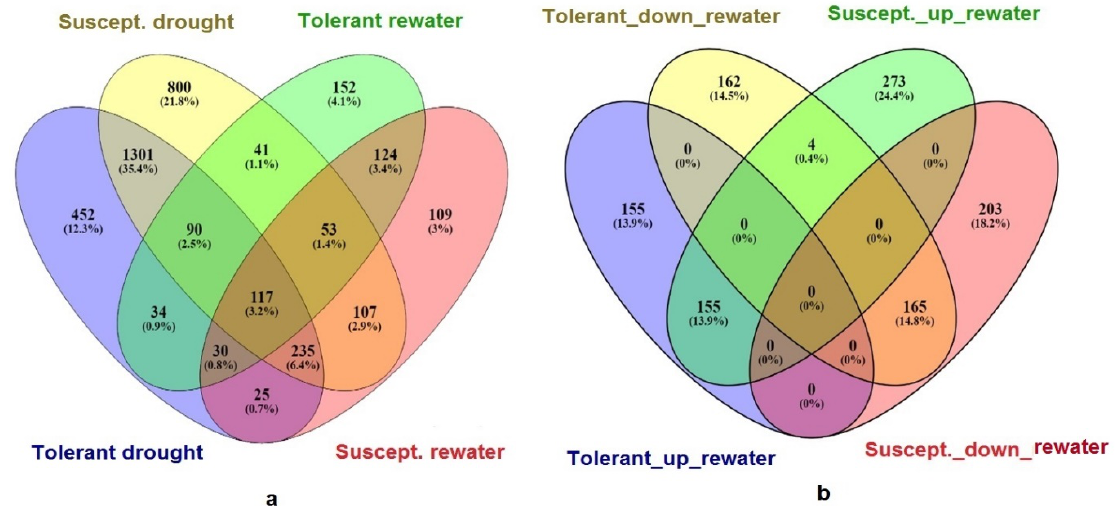
Figure 8. Differential expression of transcripts in drought tolerant (tol) and susceptible (sus) maize genotypes, under drought stress and drought recovery (rewater). ( a ) Distribution of total number of transcripts in the two genotypes under different conditions. ( b ) Number of transcripts up- and downregulated in the genotypes during recovery from